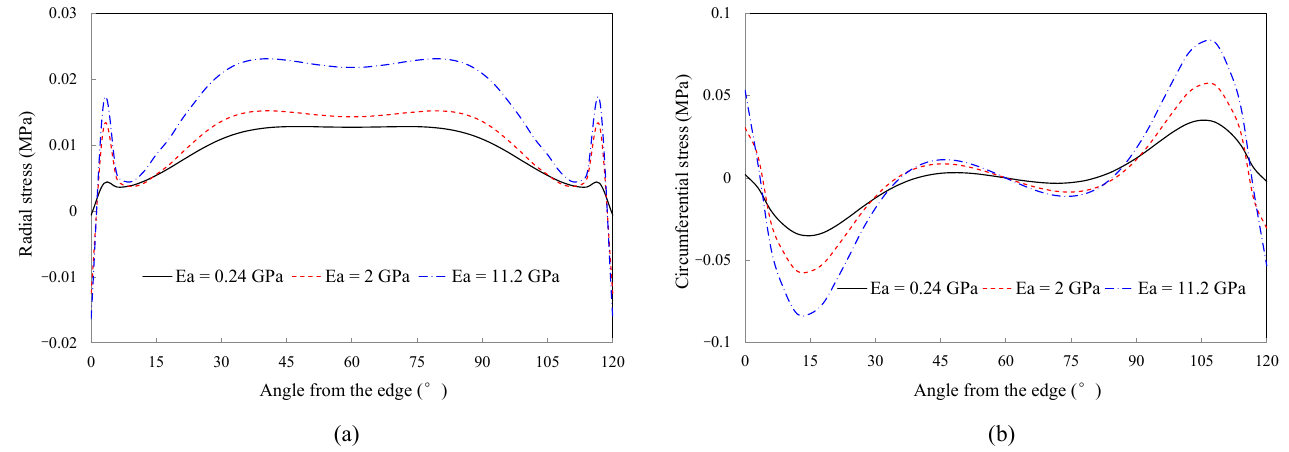
Figure 14. Effect of E a on the reinforced interface stresses: ( a ) radial stress; ( b ) circumferential stress.